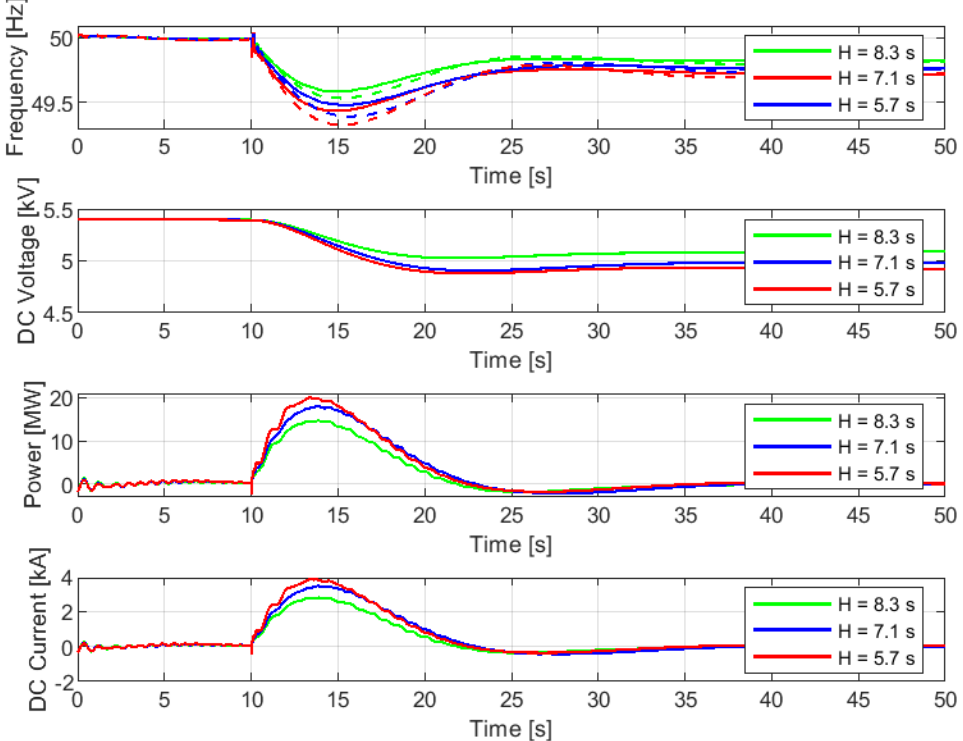
Figure 9. FFR provision from the directly connected SC in systems with different inertia constants (from top to bottom: system frequency (solid lines—cases with control, dash lines—cases without